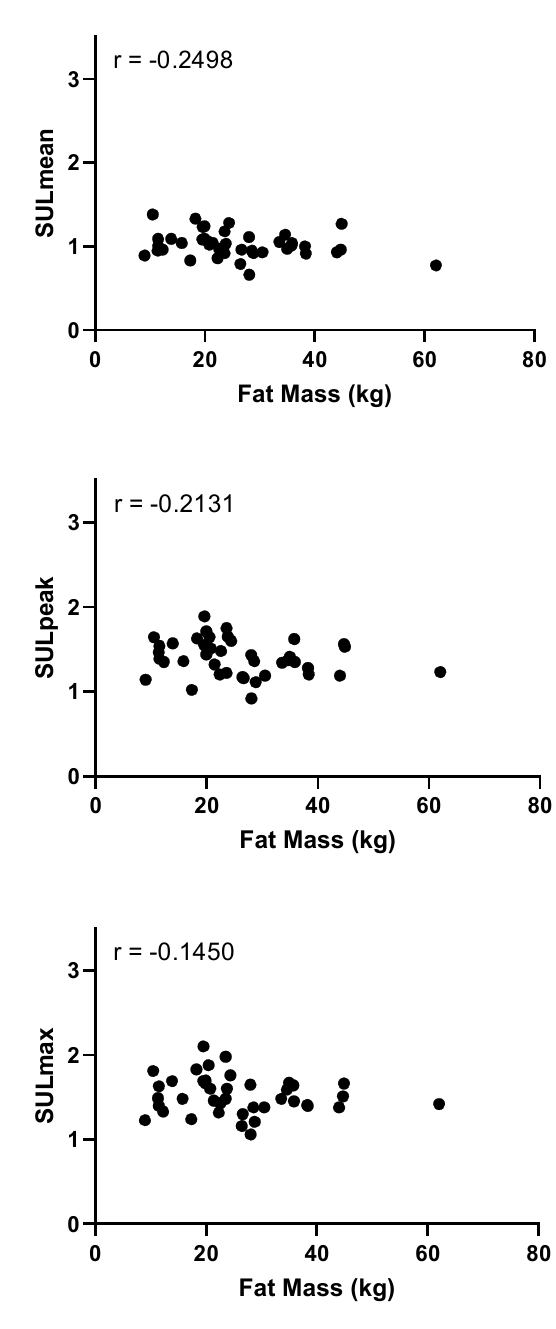
Figure 4. Plots of fat mass in kilograms and blood pool activity as measured by the mean standardized uptake value (SUV mean ), peak standardized uptake value (SUV peak ), maximum standardized uptake value (SUV max ), mean standardized uptake value corrected for lean body mass (SUL mean ), peak standardized uptake value corrected for lean body mass (SUL peak ), and maximum standardized uptake value corrected for lean body mass (SUL max ). Fat mass was calculated by subtracting the lean body mass from the total body weight. Pearson’s r values are shown in the upper left corners, with p < 0.001 (SUV mean ), p < 0.0001 (SUV peak ), p < 0.0001 (SUV max ), and no statistical significance for SUL mean ( p = 0.346), SUL peak ( p = 0.362), and SUL max ( p = 0.366).